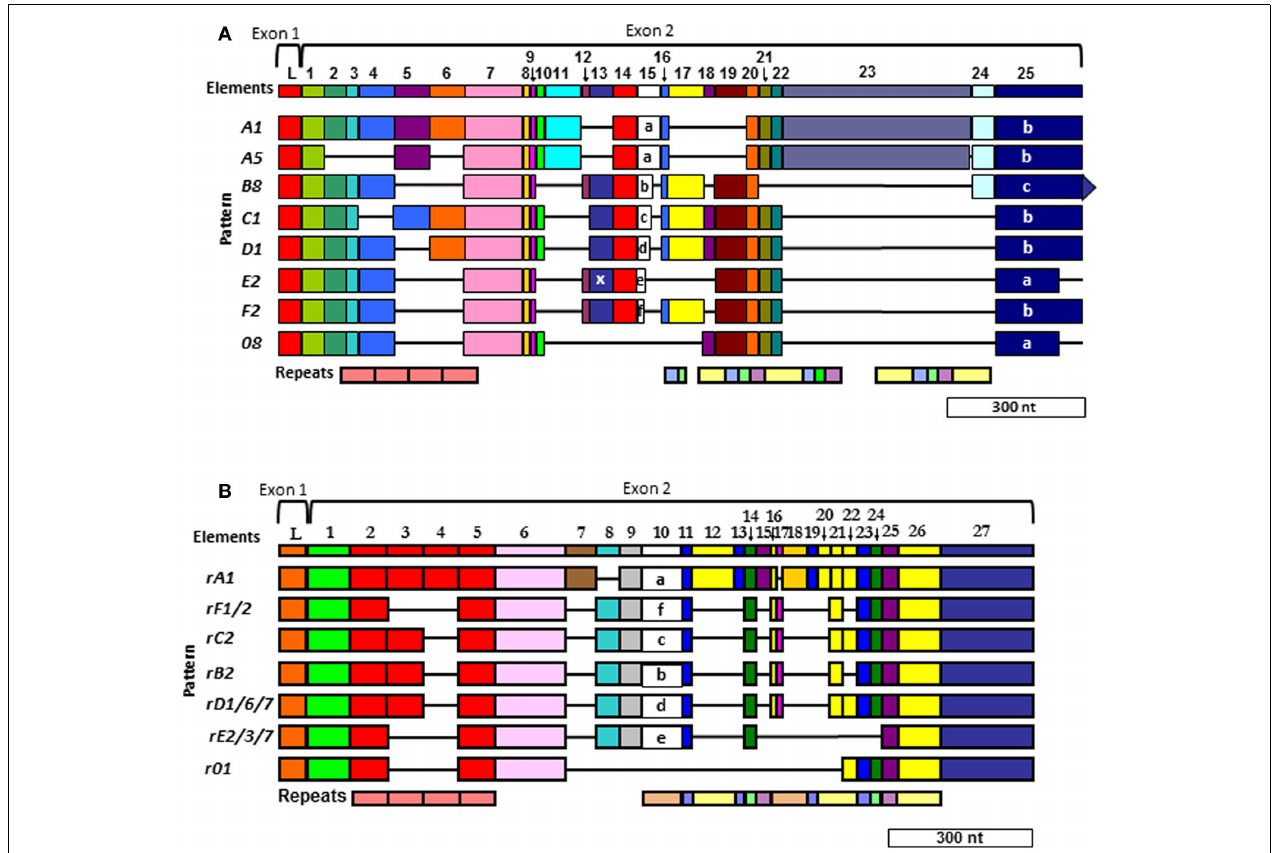
There are three types of element 25 in (A) (a, b, and c), which are defined by the location of three possible stop codons. A common, single nucleotide RNA edit in element pattern E2 alters a glycine codon to a stop (X) in element 13 and is denoted as an E2.1 pattern. Repeats, shown at the bottom of (A,B) , are shows as different colors and occur as tandem repeats and interspersed tandem repeats.The genes have two exons (brackets at the top of each alignment), of which the first encodes the leader and the second encodes the mature protein including all of the elements. A single intron of ∼ 400nt is positioned between the leader and the first element and is not shown. Modified from Ghosh et al. (2010) with permission from